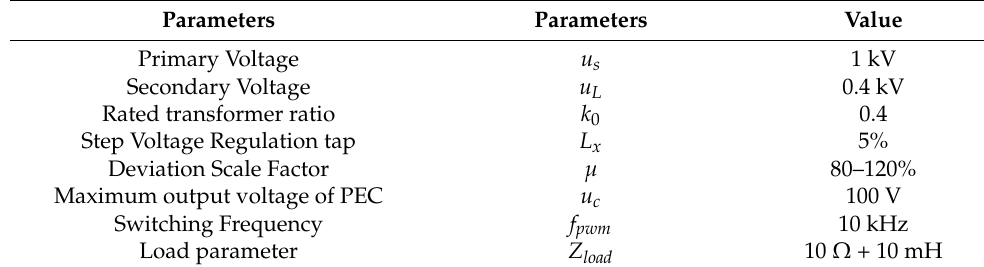
Table 2. Major parameters of experiment circuit.